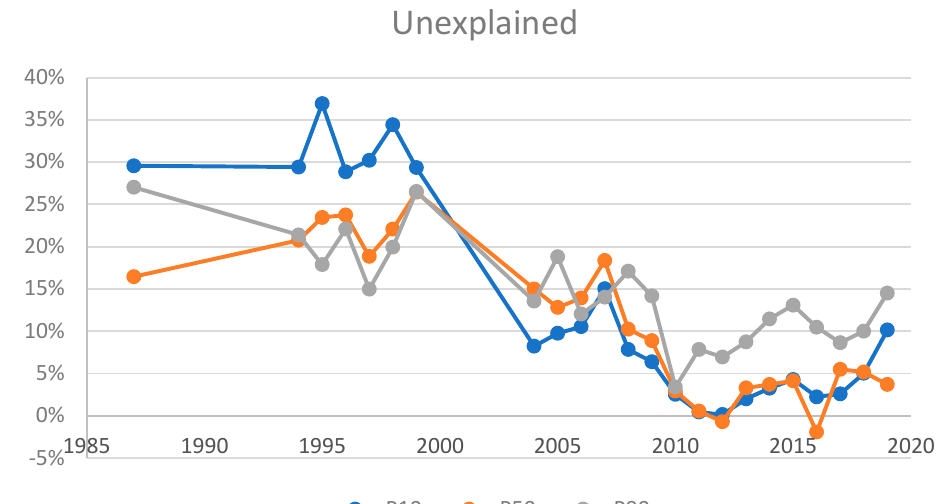
Figure 5. The explained and unexplained portions of the gender wage gap at selected quantiles.